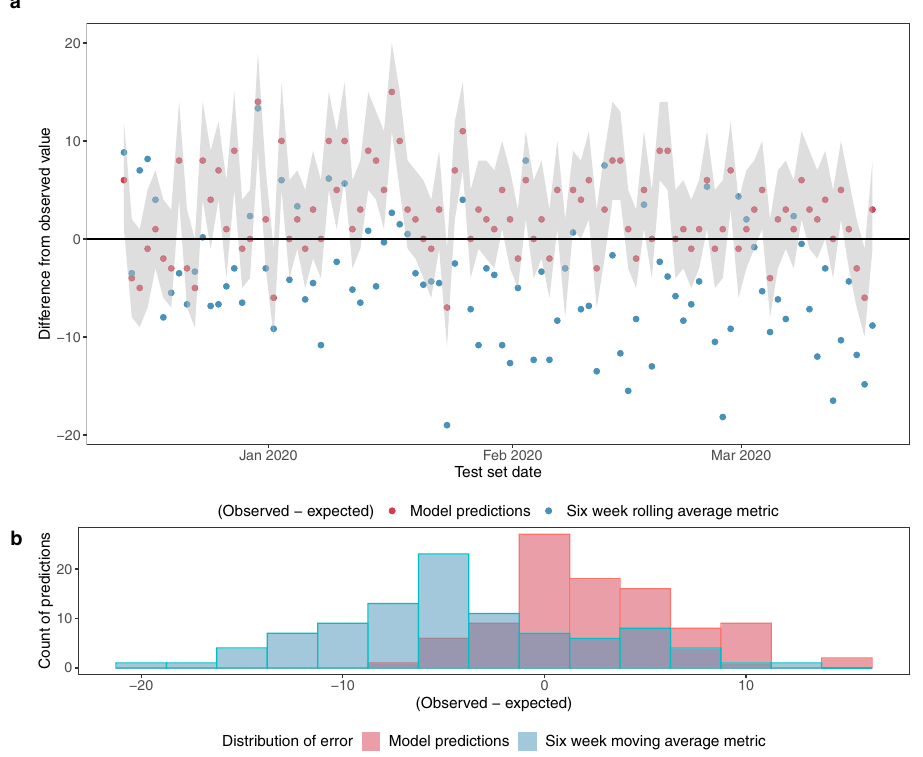
Fig. 6 Comparing model predictions with six week rolling average benchmark for number of admissions within a prediction window of 8 hours after 16:00, including patients who are yet to arrive. a Shows the difference between the observed number of admissions and the expected value from the probability distribution for the model predictions (the red dots) and between the observed number of admissions and expected value from the benchmark (the blue dots). Where the expected value equals the observed value, the dots fall on the x axis ( y = 0). The grey shaded band represents the range of probability between the 10 th and the 90 th centile of the cumulative probability distribution of the model. b Shows the distribution of errors (difference between observed and expected). See Methods for a rationale for conducting the evaluation at 16:00 with an 8-hour prediction